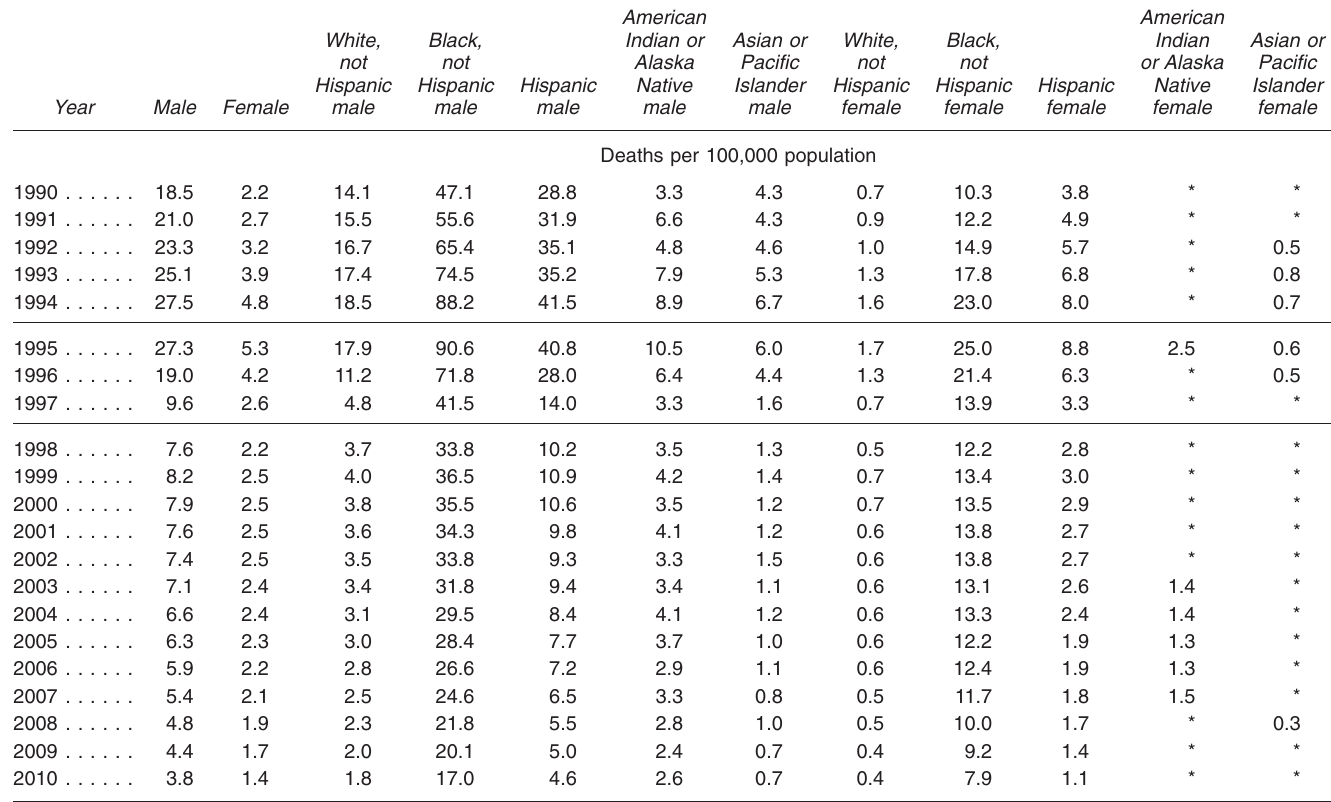
Data table for Figure 24. Age-adjusted death rates for human immunodeficiency virus (HIV) disease for all ages, by sex and race and Hispanic origin: United States, 1990–2010 Excel and PowerPoint: